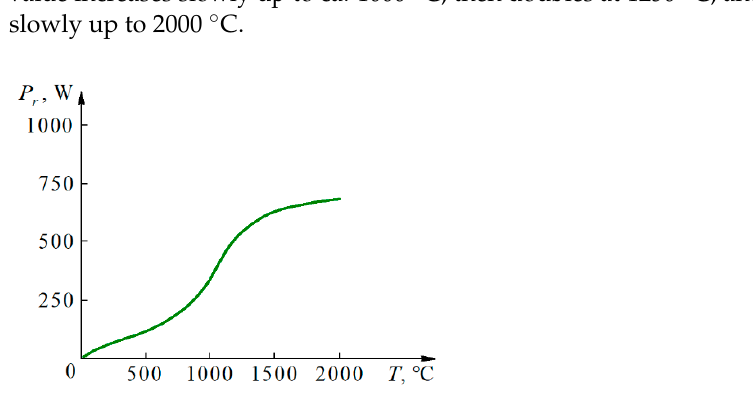
r versus temperature.